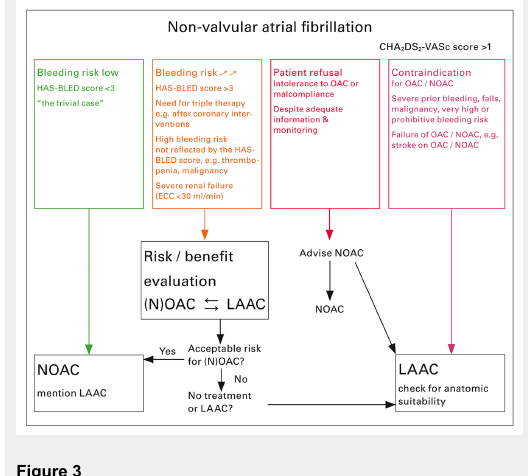
Recommended algorithm for stroke prevention in patients with atrial fibrillation (reproduced modified from the 2014 expert consensus statement of the European Heart Rhythm Society and the European Association of Percutaneous Cardiovascular Interventions [50]). The additional strategy of LAAC centres on a risk/benefit evaluation of the optimal treatment for each patient. Hereby, it is supposed to contribute both to improved safety and efficacy outcomes as well as to offer protection from stroke and death to patients who have been left without any treatment so far. LAAC = left atrial appendage closure; NOAC = non-vitamin K-